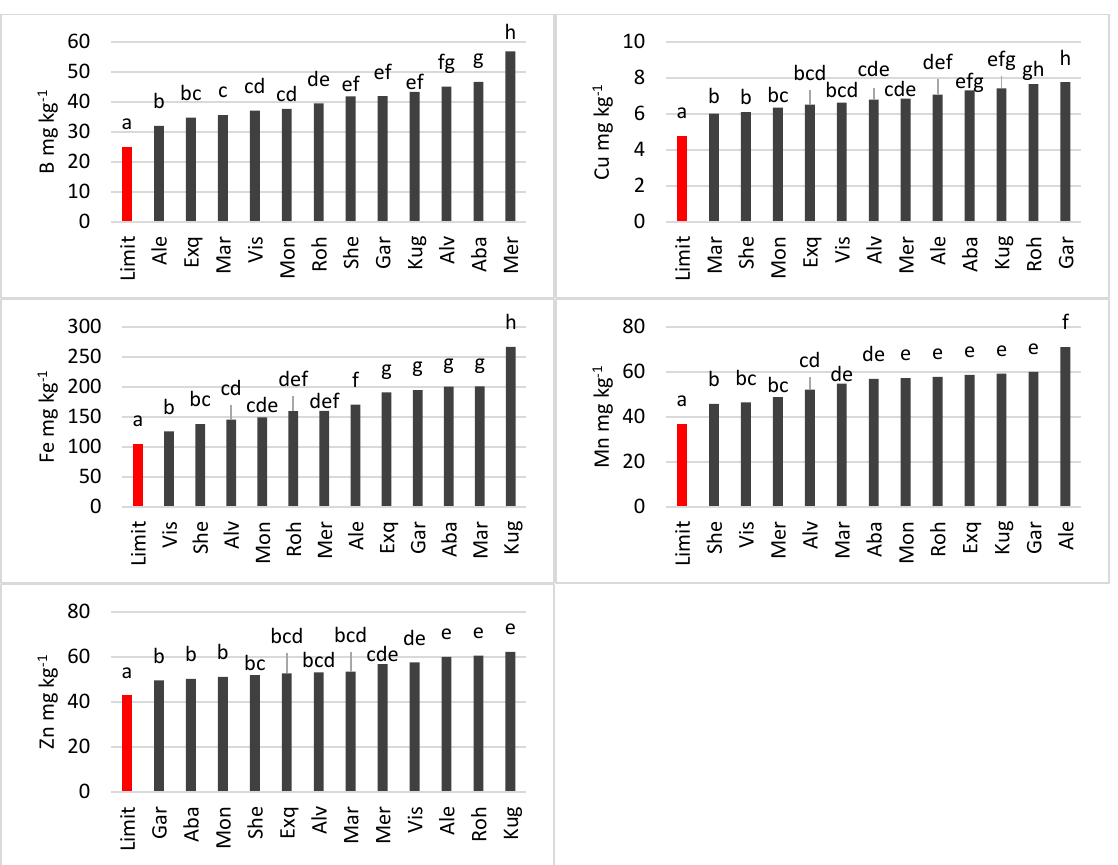
Figure 6. Concentration of microelements in shoots of oilseed rape cultivars. Bars marked with the same letters indicate no significant difference according to Tukey ’ s test ( p < 0.05).